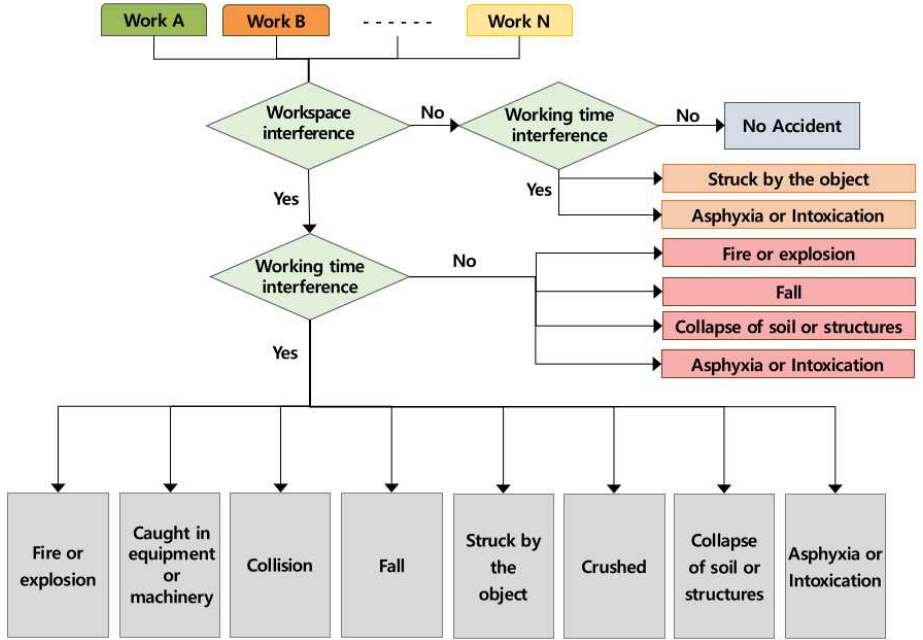
Figure 3. Accident occurrence mechanism by multiple processes in the workplace (AMMP model).